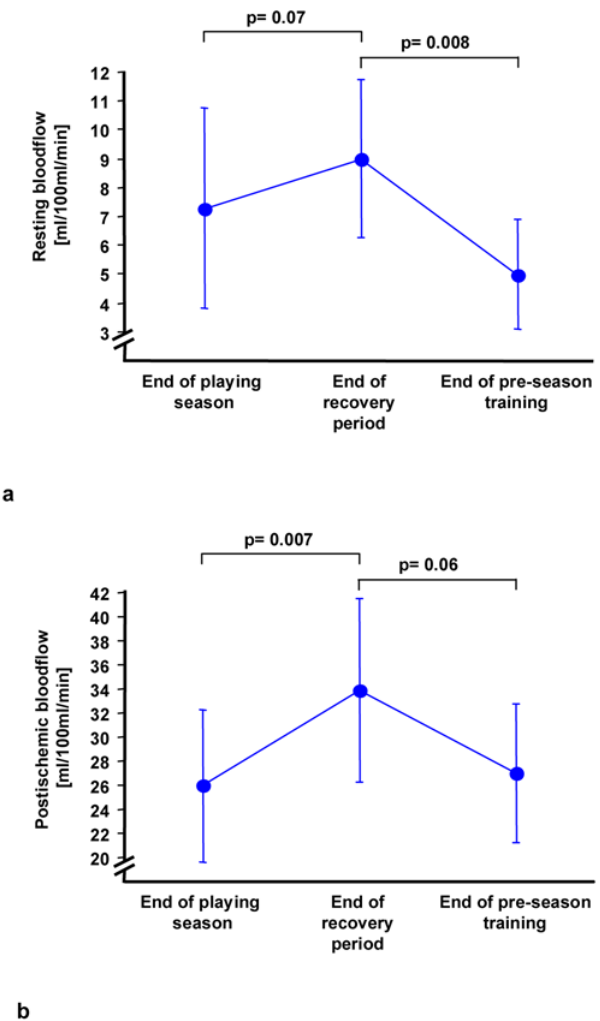
Figure 3. Enhanced resting and postischemic blood flow during the recovery period.